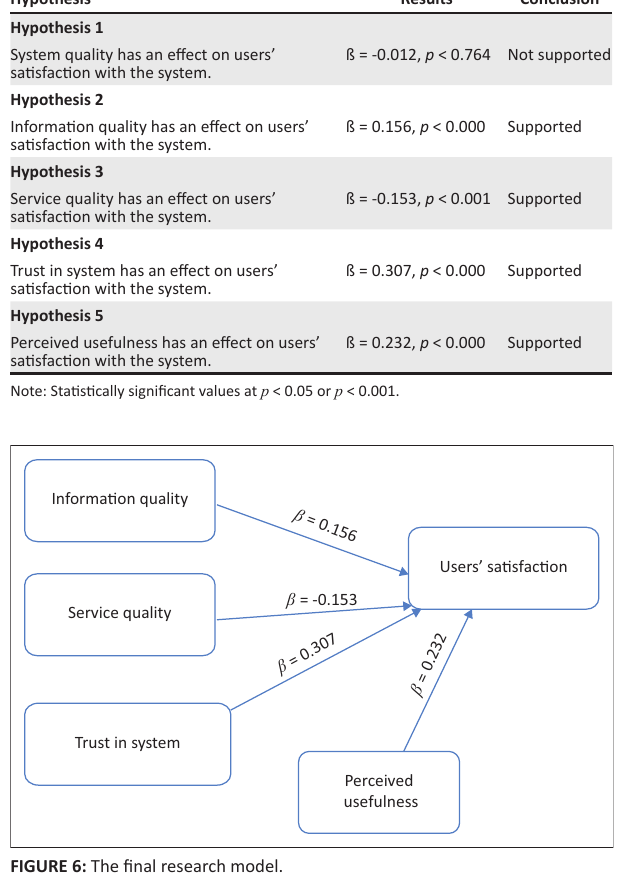
TABLE 6: Summary of results hypothesis testing.